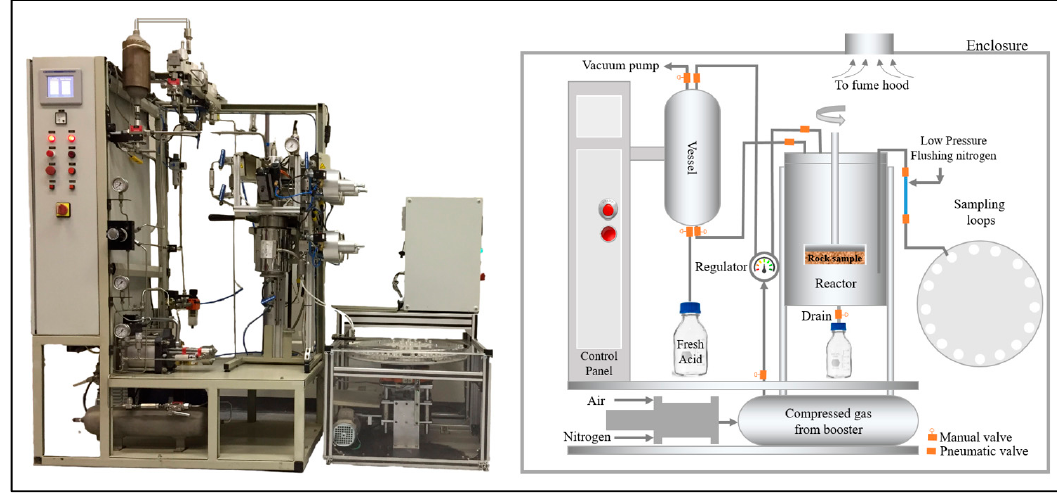
Figure 3. Rotating disk apparatus with a schematic showing the main components.